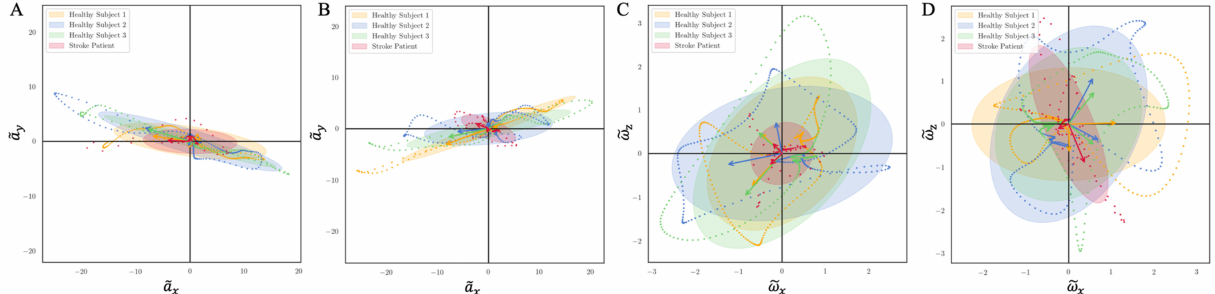
Figure 13. Planar 2-D projection of secondary signals ( A ) from a healthy subject. Green star markers: HS. Blue circle markers: TO. Green line: stance phase. Blue line: swing phase.